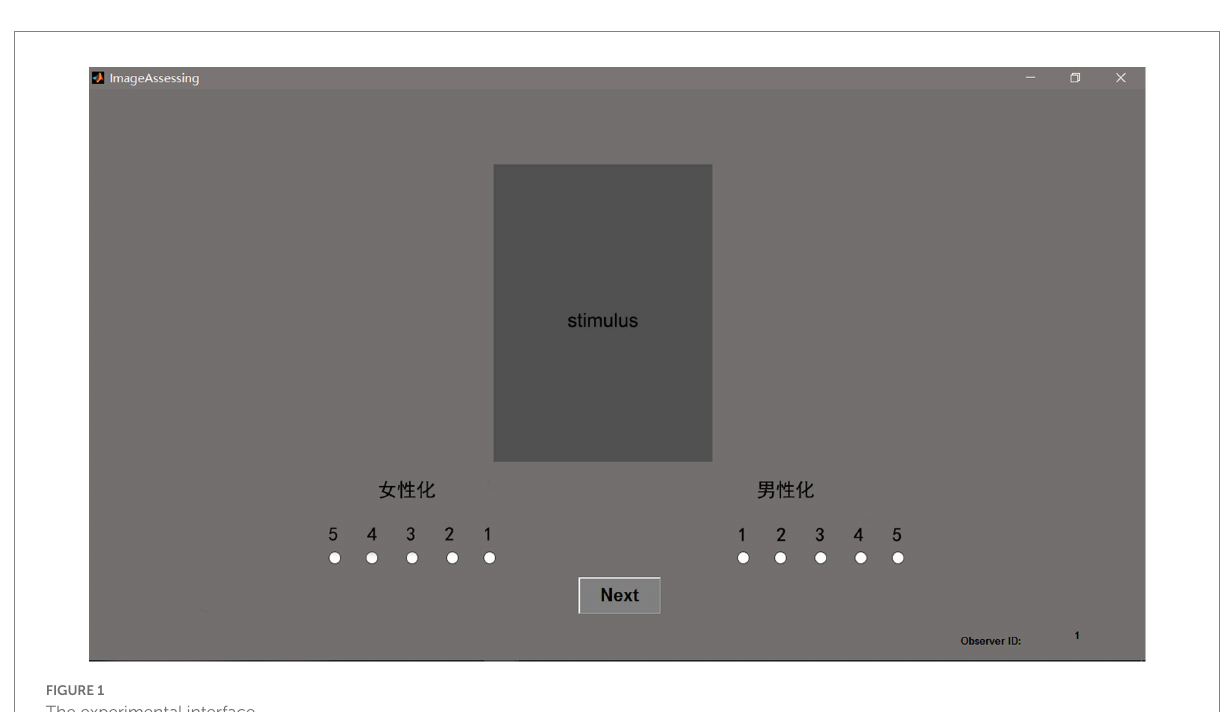
FIGURE 1 The experimental